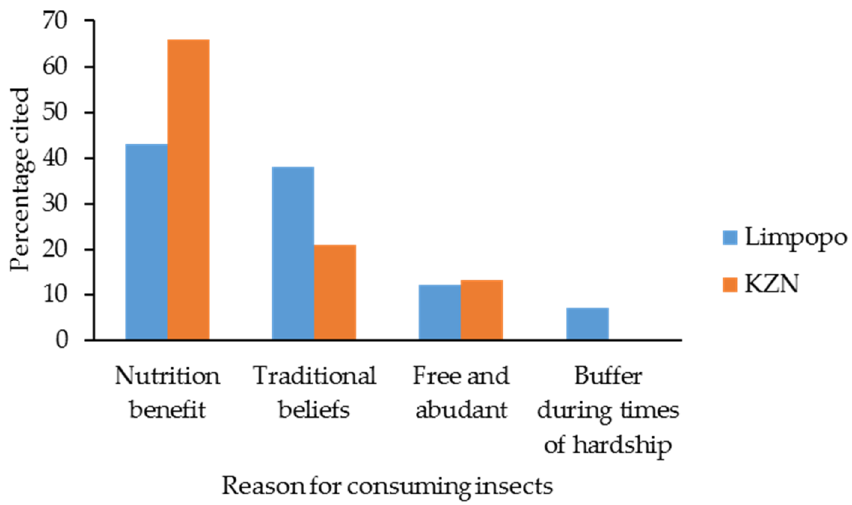
Figure 1. Reasons for consuming insects in Limpopo and KZN provinces of South Africa.